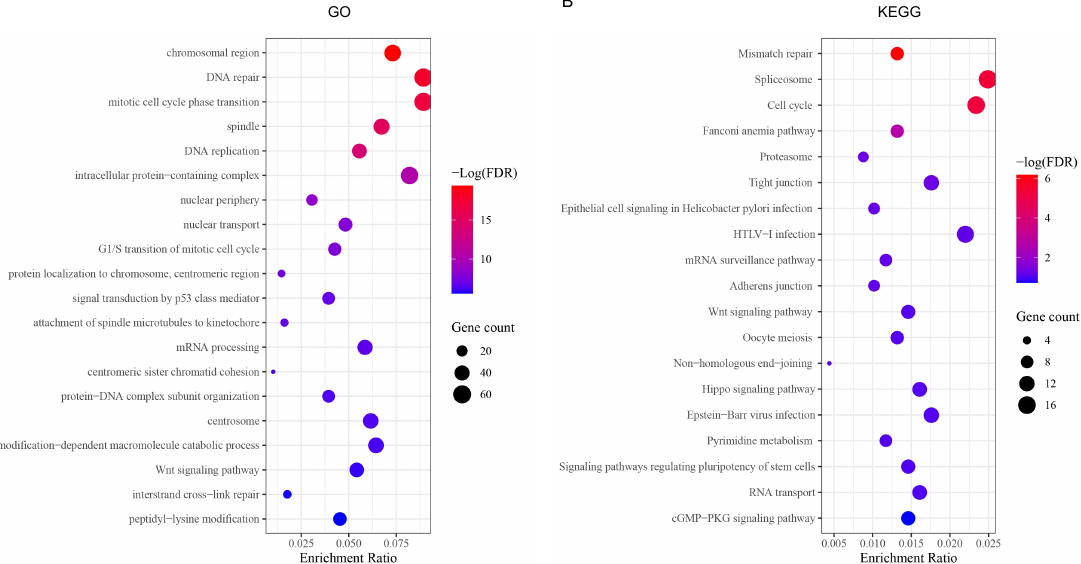
Figure 6. GO and KEGG analysis of CBX family proteins in EC. ( A ) Gene ontology (GO) enrichment of CBXs in EC; ( B ) Kyoto Encyclopedia of Genes and Genomes (KEGG) pathways of CBXs in